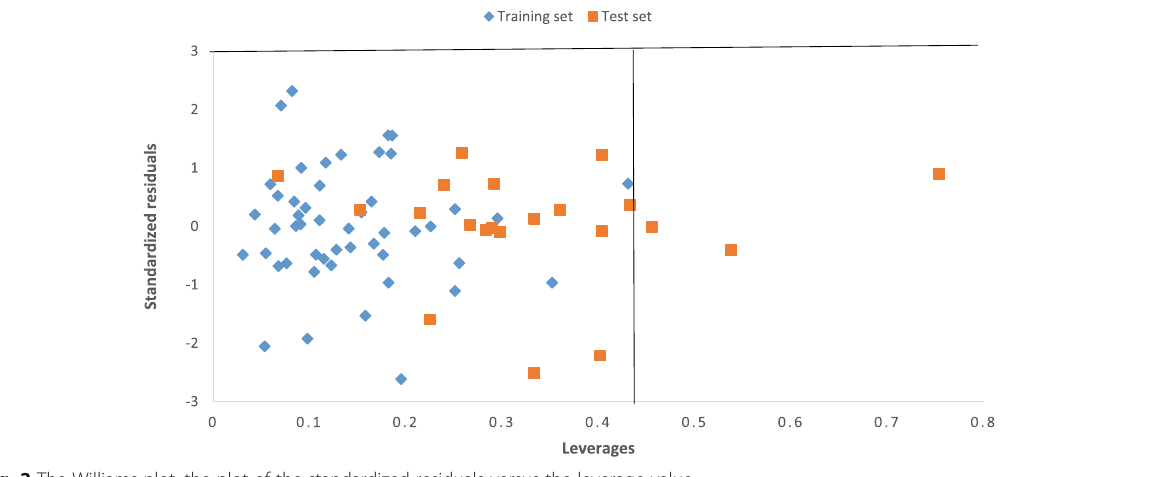
Fig. 2 The Williams plot, the plot of the standardized residuals versus the leverage value